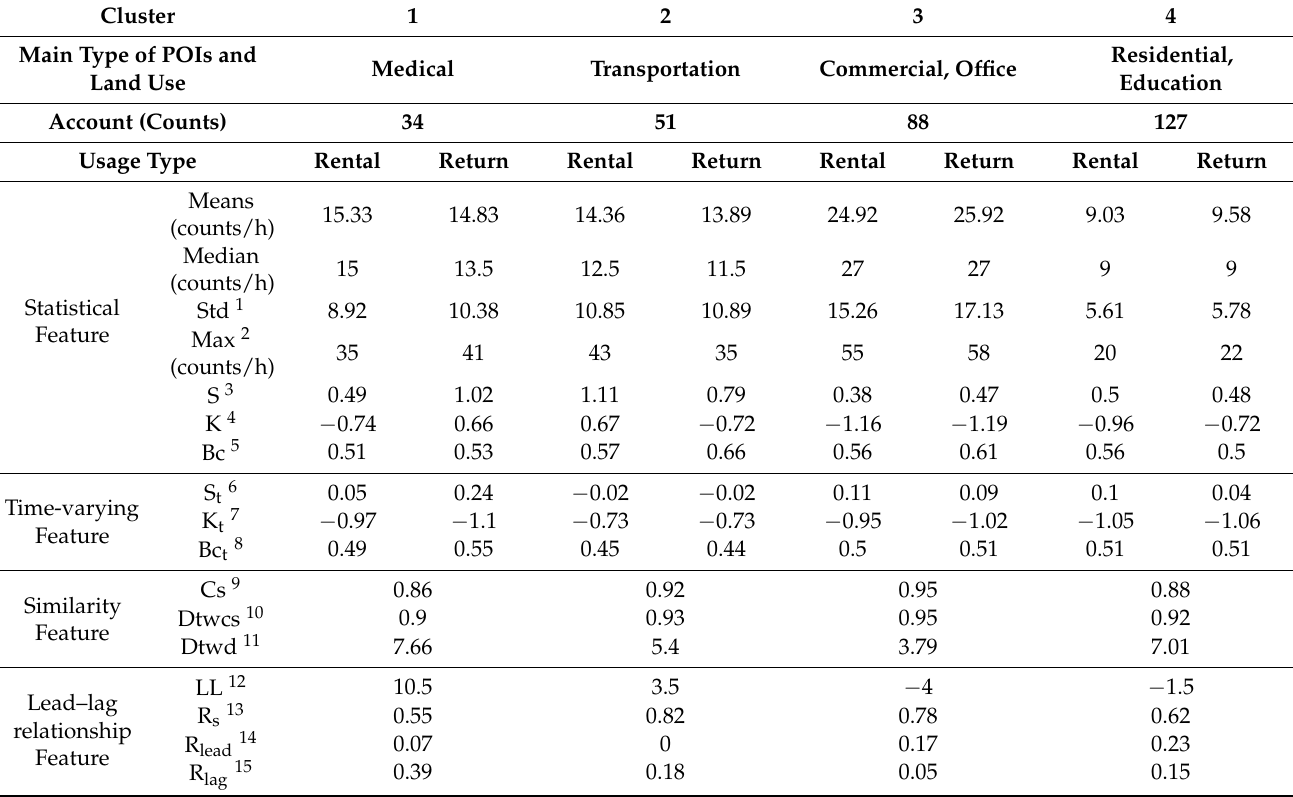
Table 5. Full-day hire and return characteristics of four clusters of PB rental